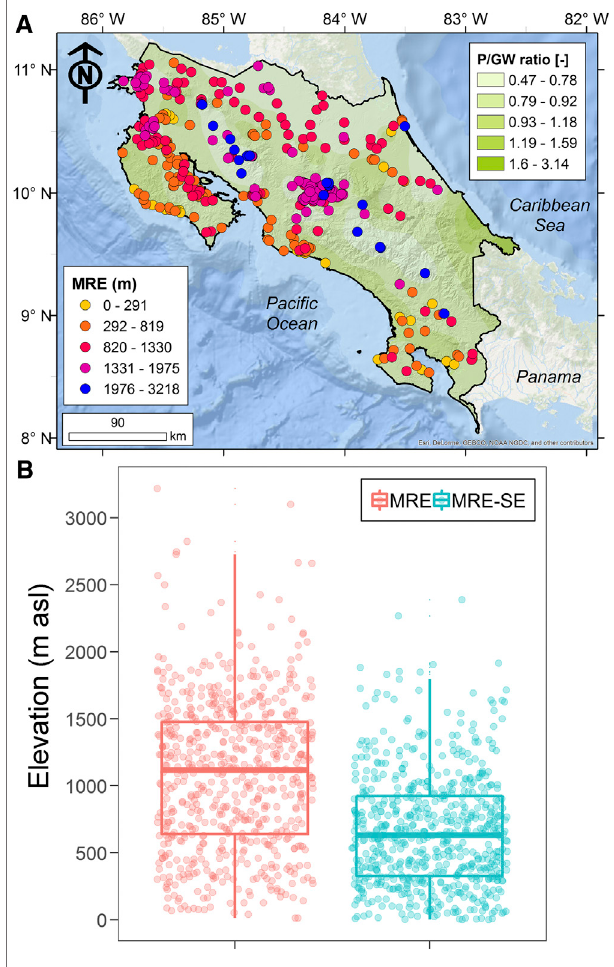
FIGURE12| Spatialand altitudinalgroundwaterrecharge variations. (A) Spatial classi fi cation (green colors) of rainfall to groundwater (P/GW) δ 18 O ratios [ − ] for Costa Rica (Sánchez-Murillo and Birkel, 2016). Colored dots represent potential mean recharge elevations (MRE in m asl). B) Scatter and box plots showing the disproportionality between MRE and sampling elevations (SE). MRE-SE represents the difference between both elevations. Figure adapted using data from Sánchez-Murillo and Birkel (2016) and Sánchez-Murillo et al.